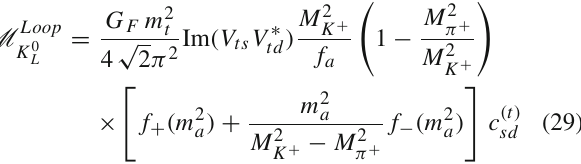
with q = P M − P P . The form factors f + , 0 ( 0 ) = 1 in the isospin symmetric limit, while the non approximated, q 2 dependent, form factors are obtained from LQCD calcula- tion